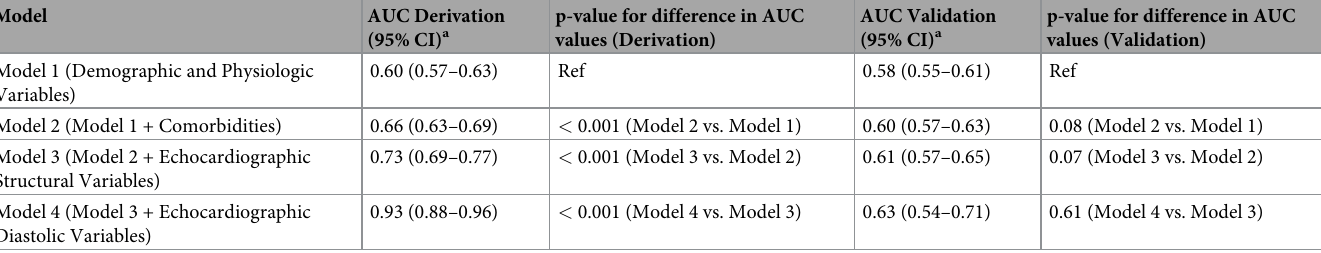
Table 3. Comparison of nested logistic regression models to predict heart failure readmission in derivation and validation samples.